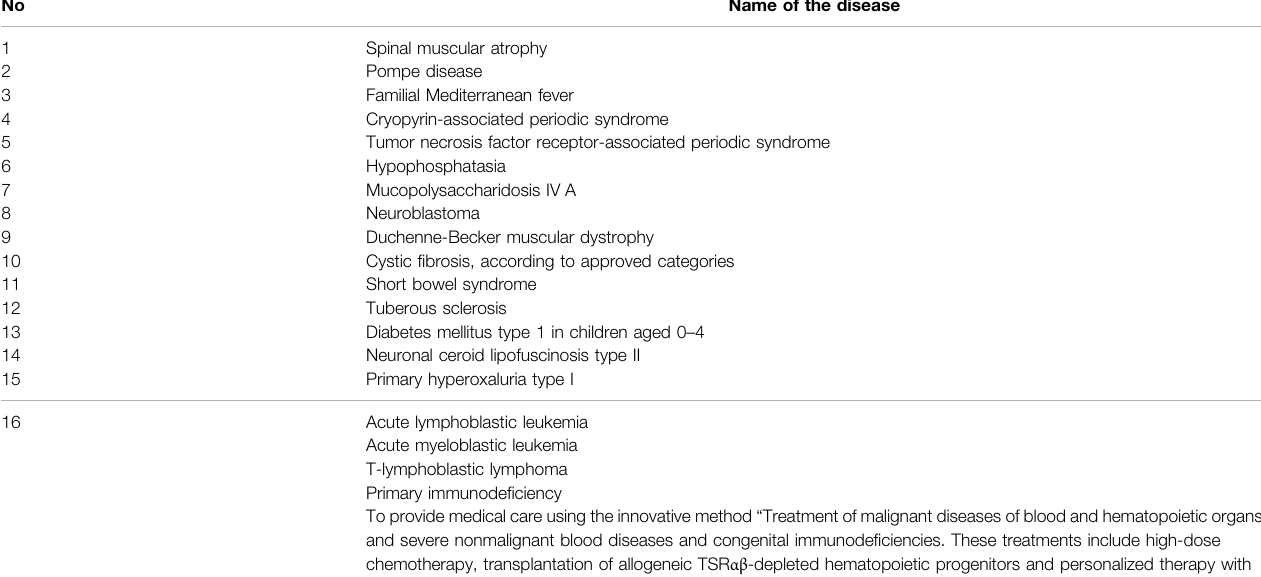
TABLE 3 | The supplementary list of life-threatening and chronic progressive rare diseases, leading to a reduction in life expectancy of citizens or their disability.